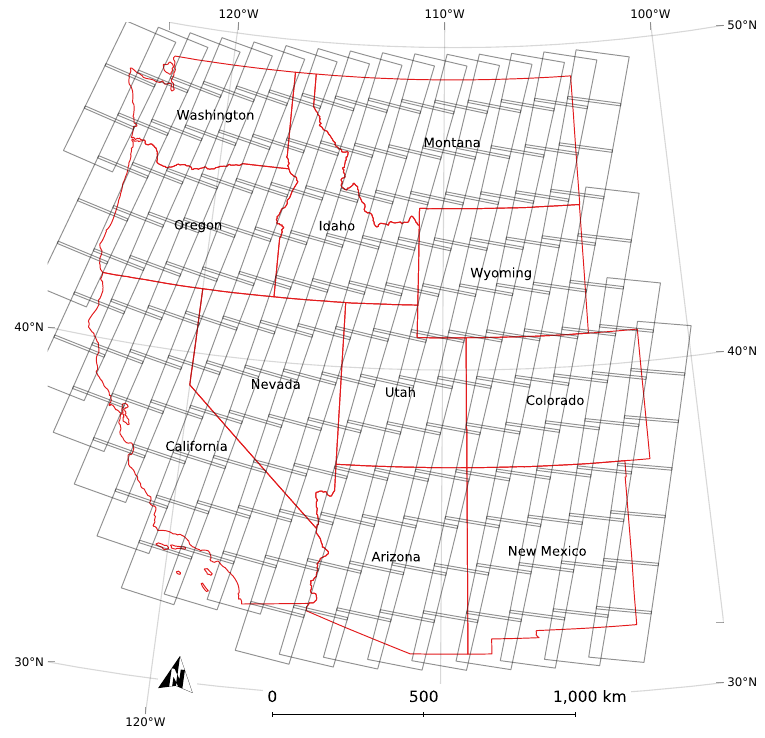
Figure 1. The 11 states of the Western U.S. included in our study area displayed with the 186 Landsat scene footprints from which imagery was